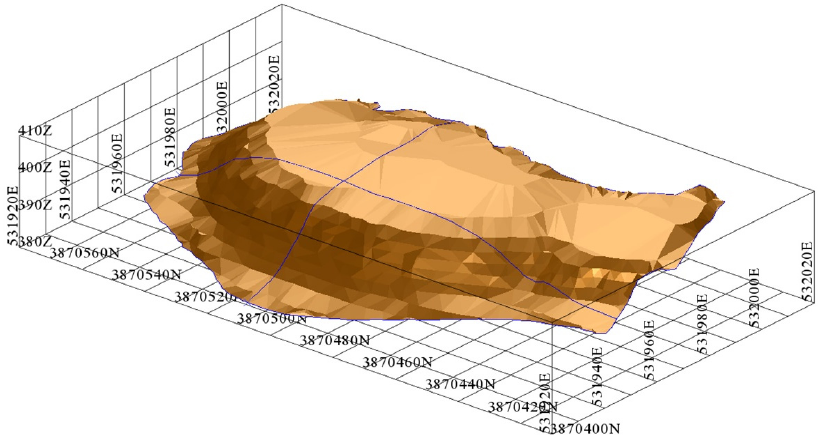
Figure 14. Final stockpile STK1 of 56,000 m 3 with the traces of two sections in NS and WE direction.